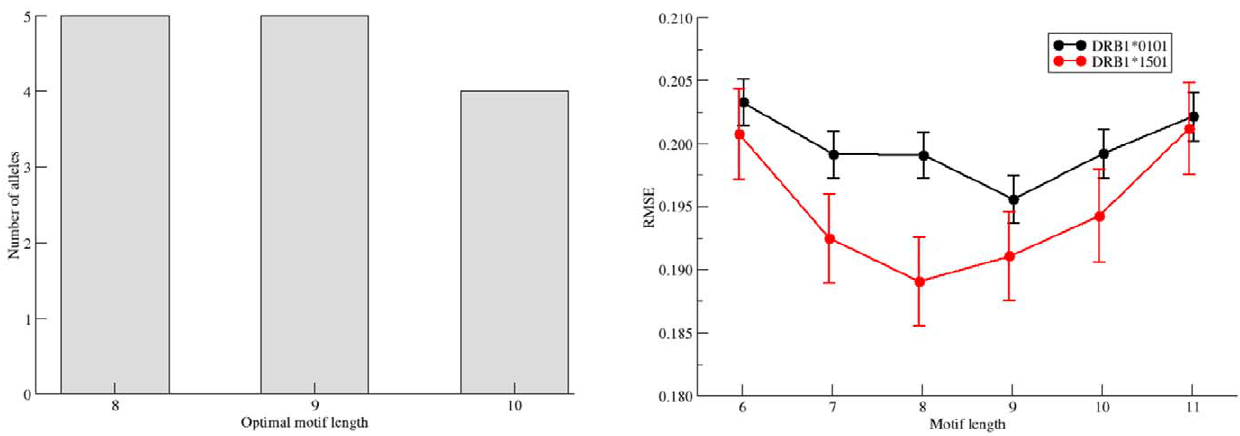
Figure 2. Identification of optimal motif length using the NNAlign method. Left panel: Histogram of the optimal motifs lengths for the 14 HLA-DR molecules in the Wang dataset as identified by the NNAlign method. Right panel: Predictive performance measured in terms of the root mean square error (RMSE) between observed and predicted values as a function of the motif length for the two molecules DRB1*0101 and DRB1*1501. NNAlign was trained using the same parameters settings described in Figure 4. At each motif length are shown the mean and standard error of the mean RMSE as estimated by bootstrap sampling. For DRB1*0101 a single consistent optimal motif length of 9 amino acids is found. For DRB1*1501 all motif length 8–11 had statistically indistinguishable performance (paired t-test).